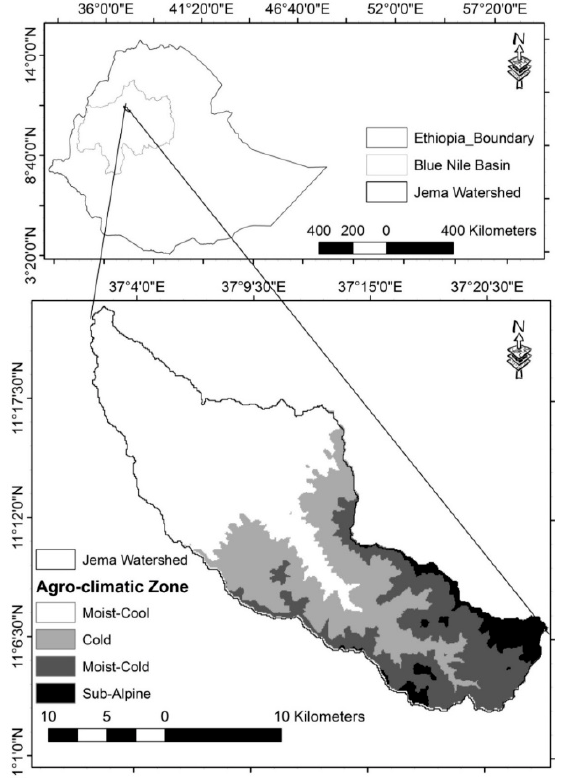
Figure 1. Location map of the Jema watershed and its agro-ecological zones.